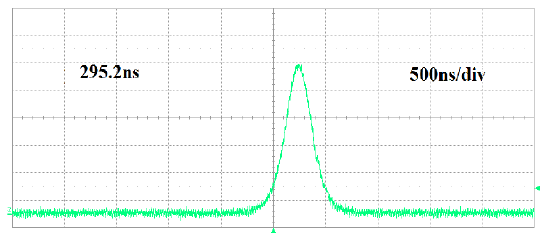
Figure 6. Temporal profile of single-pulse.